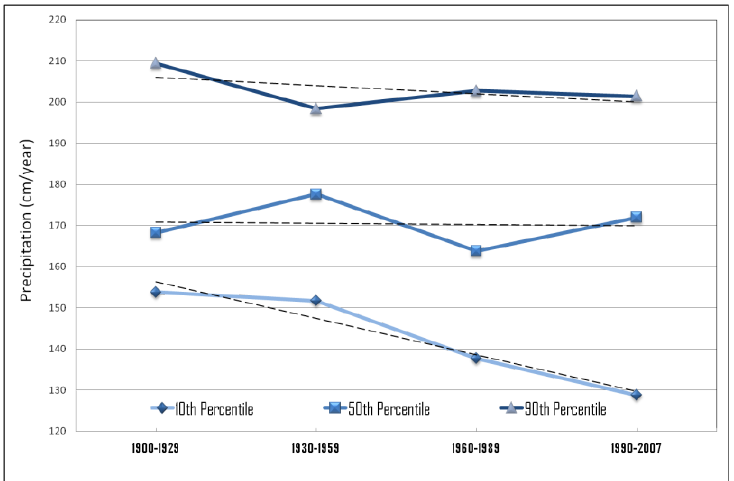
Figure 20. Annual precipitation quantiles for moist forest by